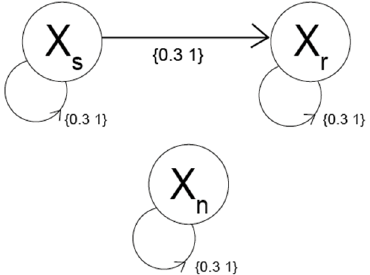
Figure 3. Ground Truth 2 with two fixed, one moving dipole.